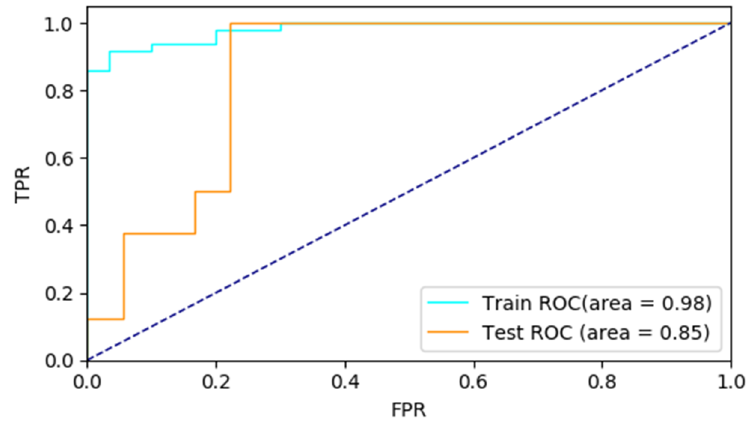
Figure 4. ROC of the multilayer perceptron classifier .